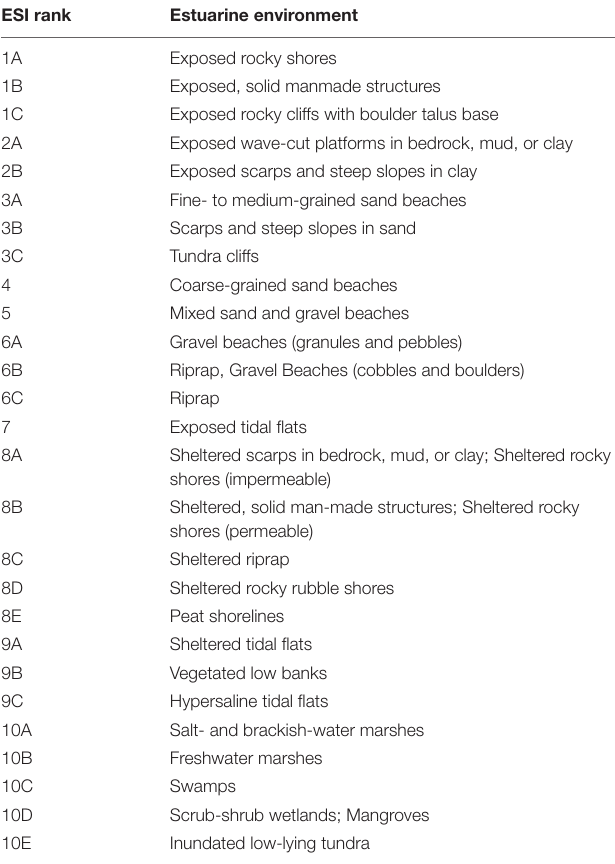
TABLE 1 | Environmental Sensitivity Index shoreline classification for vulnerability assessment of oil spill events (National Oceanic and Atmospheric Administration [NOAA], 2002;